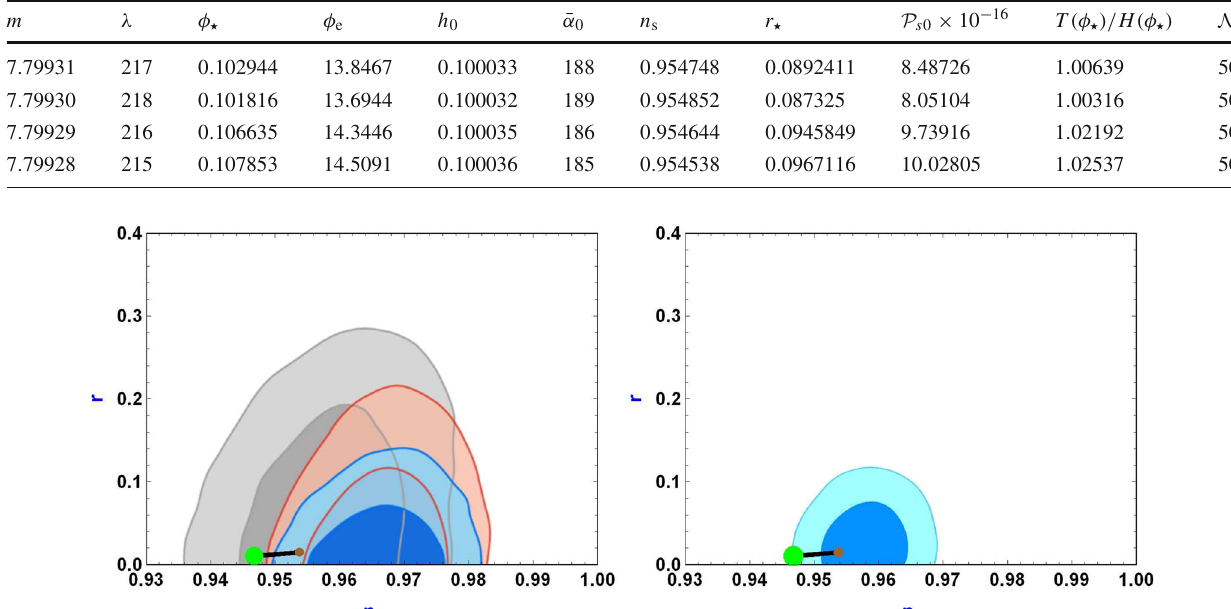
Fig. 5 The r – n s diagram comparing the predictions of the non- comoving warm inflation model in the strong dissipative regime with power-law scale factor and with the free parameters given in Table 3, with the Planck 2013, 2015 and 2018 data sets. In the left panel, the likelihood of Planck 2013 are indicated with gray contours, Planck TT+lowP with red contours, and Planck TT,TE,EE+lowP (2015) with